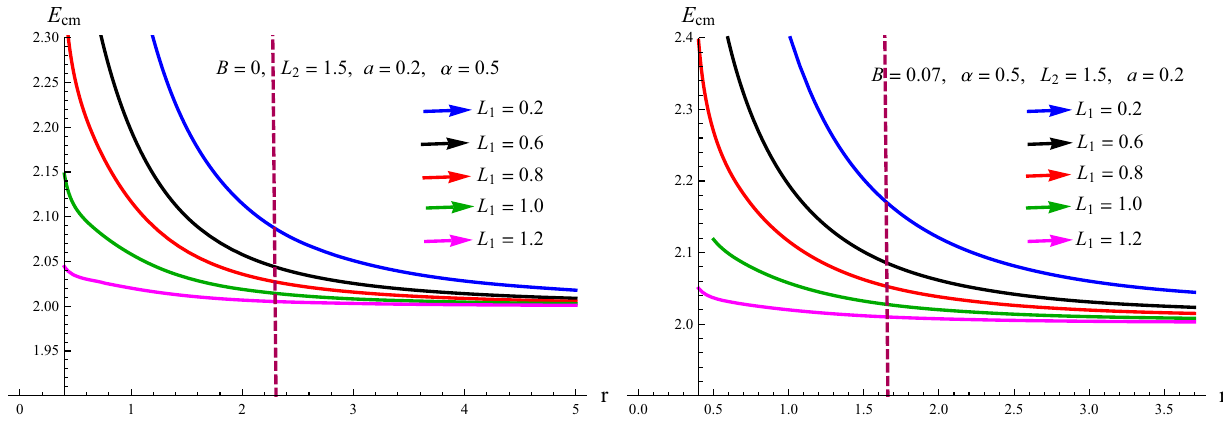
Fig. 6 The CME as a function of r . The vertical line represents the event